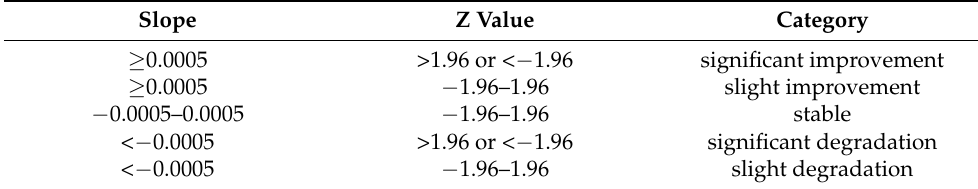
Table 6. The classification standard of ecological intactness changes categories. Slope Z Value Category ≥